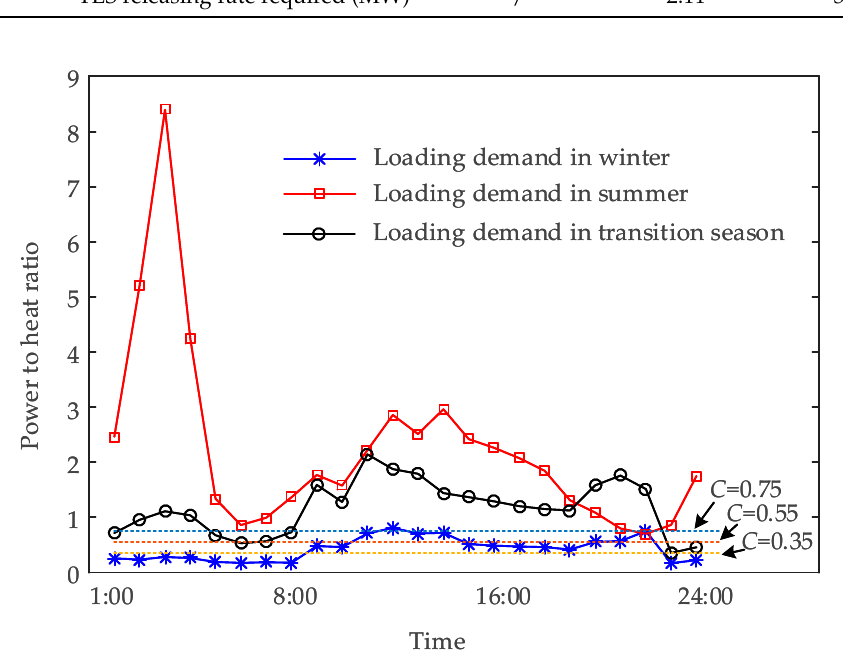
Figure 5. Power to heat ratios of demands under different seasons.